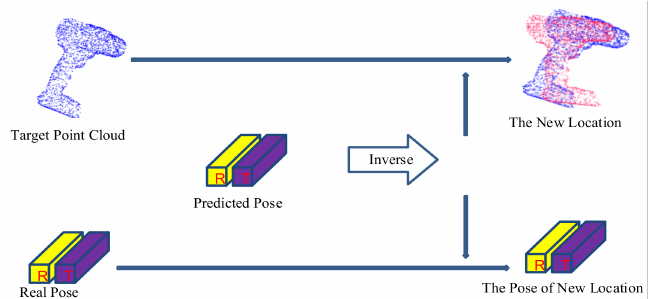
Figure 5. Pose estimation of a fine matching network. The input point cloud and the real pose are transformed according to the inverse matrix of the feature fusion network to get the new position and corresponding pose of the